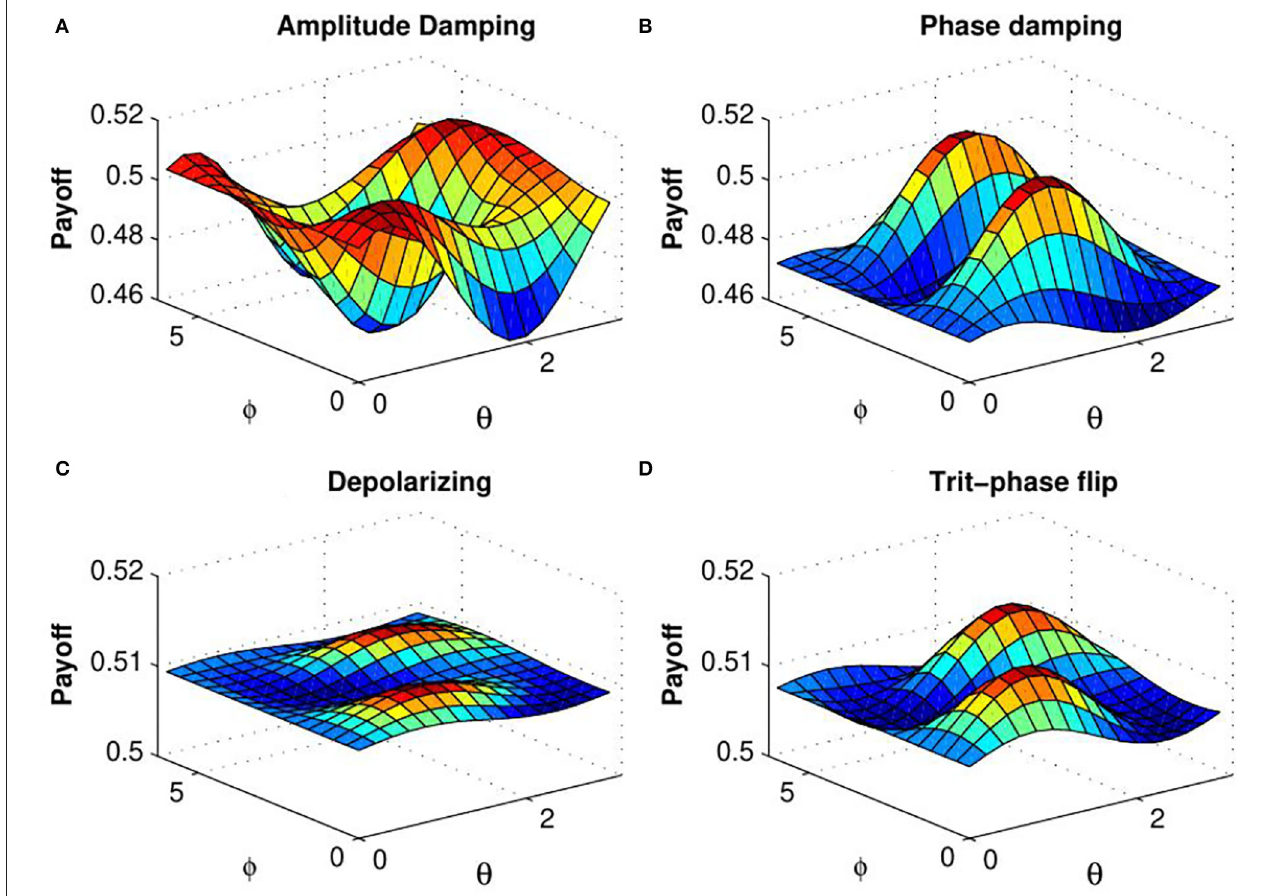
FIGURE 5 | (Color online) Alice’s expected payoff as a function of θ and φ [determined by Equation (25)] for (A) amplitude damping, (B) phase damping, (C) depolarizing, and (D) trit-phase flip channels with decoherence parameter p